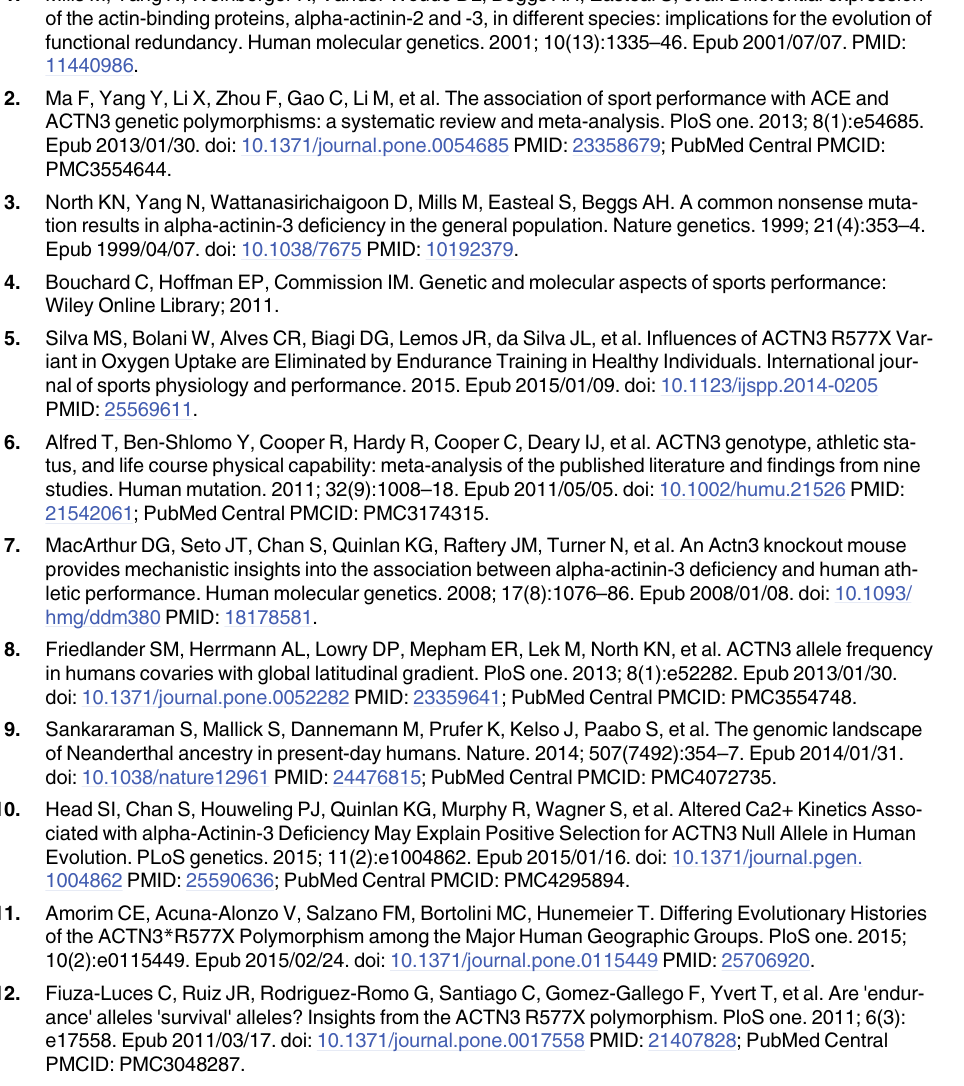
S1 Table. Comparison of Paffenbarger Survey Scores between ACTN3 genotypes. Self- reported yearly physical activity scores between ACTN3 genotypes. All analyses were per- formed by ANCOVA as described previously. No statistically significant differences were iden- tified between ACTN3 genotypes RR, RX or XX (p <